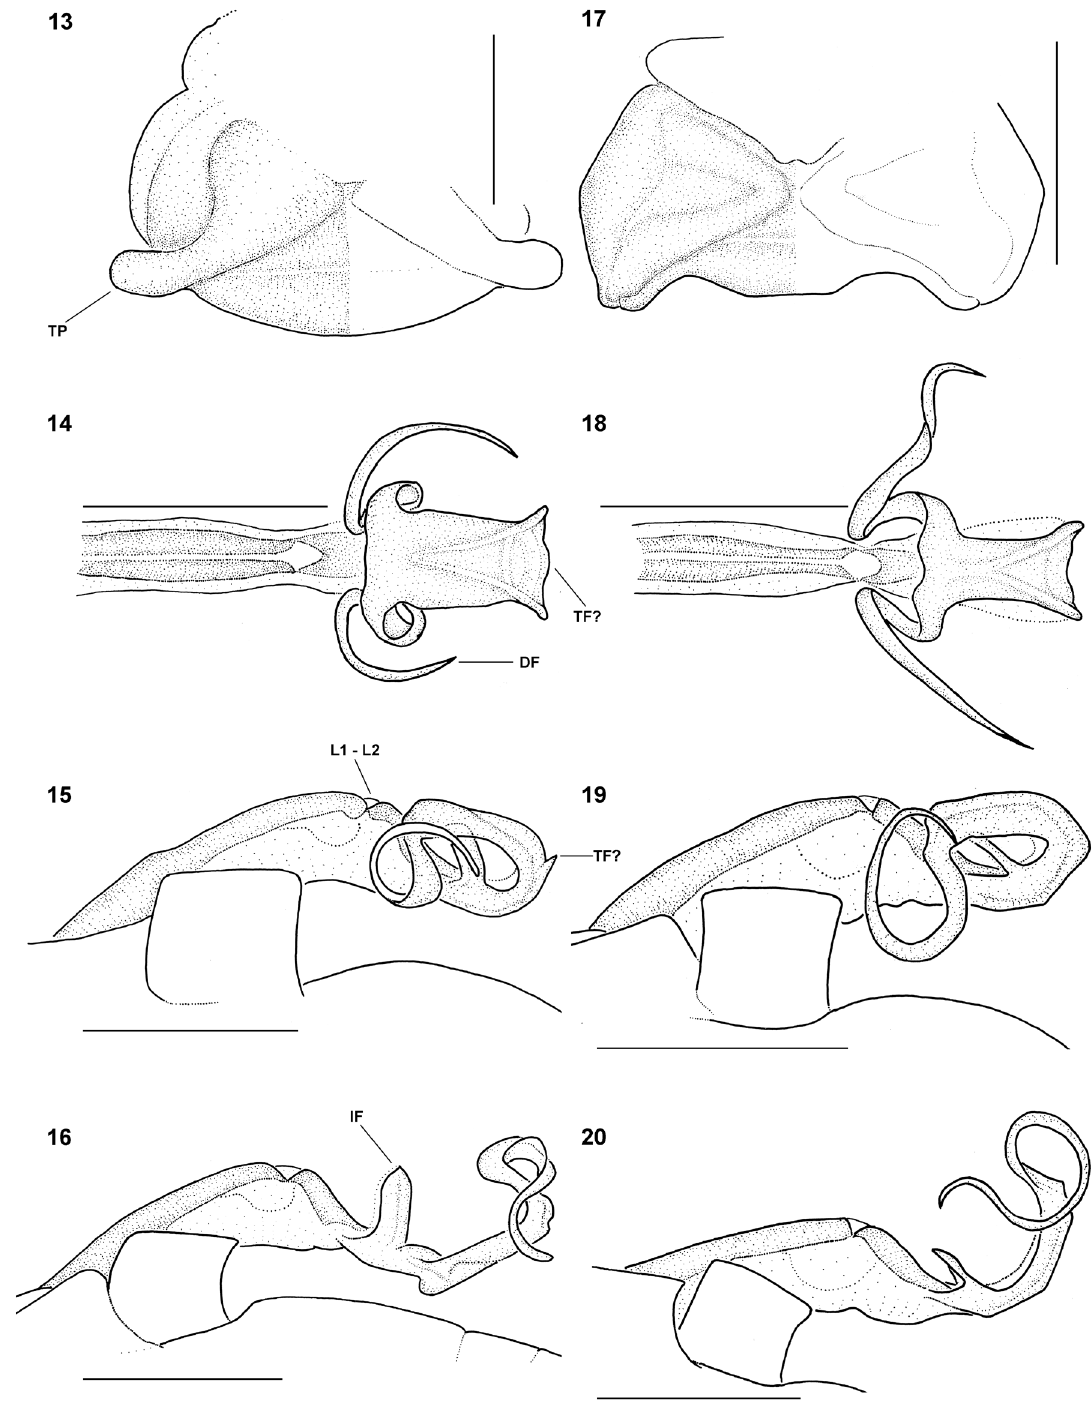
Figures 13–20. Prothorax and genital ligula of males of Forcepsioneura : (13–16) F. serrabonita sp. nov., holotype (Brazil. BA: Camacan, DZRJ 0050); (17–20) F. regua sp. nov., (17) holotype (Brazil. RJ: Cachoeiras de Macacu, DZRJ 2071), remainder from paratype of same locality; (13, 17) prothorax in dorsal view; (14–16, 18–20) genital ligula in ventral (14, 18) and lateral (15–16, 19–20) views. Scale bars = 0.5